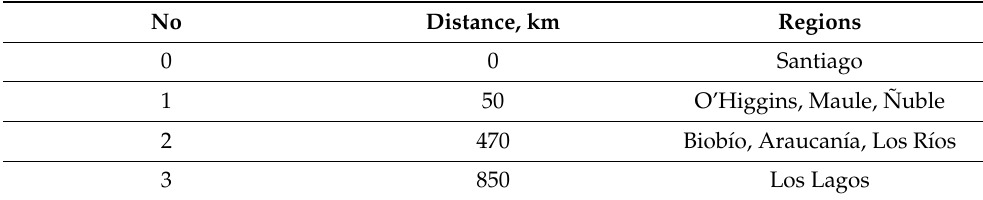
Table 3. Regions to bands correspondence to the south of Santiago in Chile.